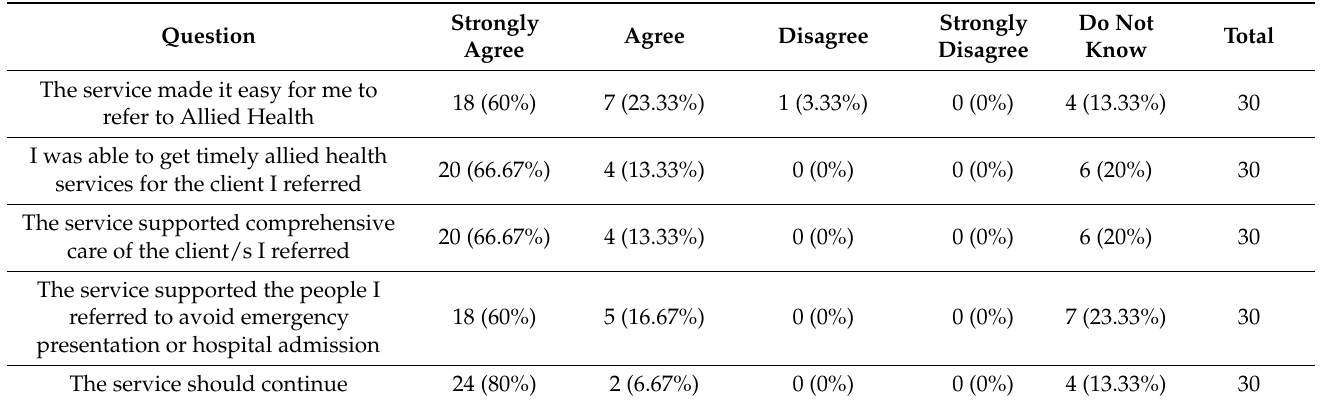
Table 6. Summary of survey responses (n = 30).